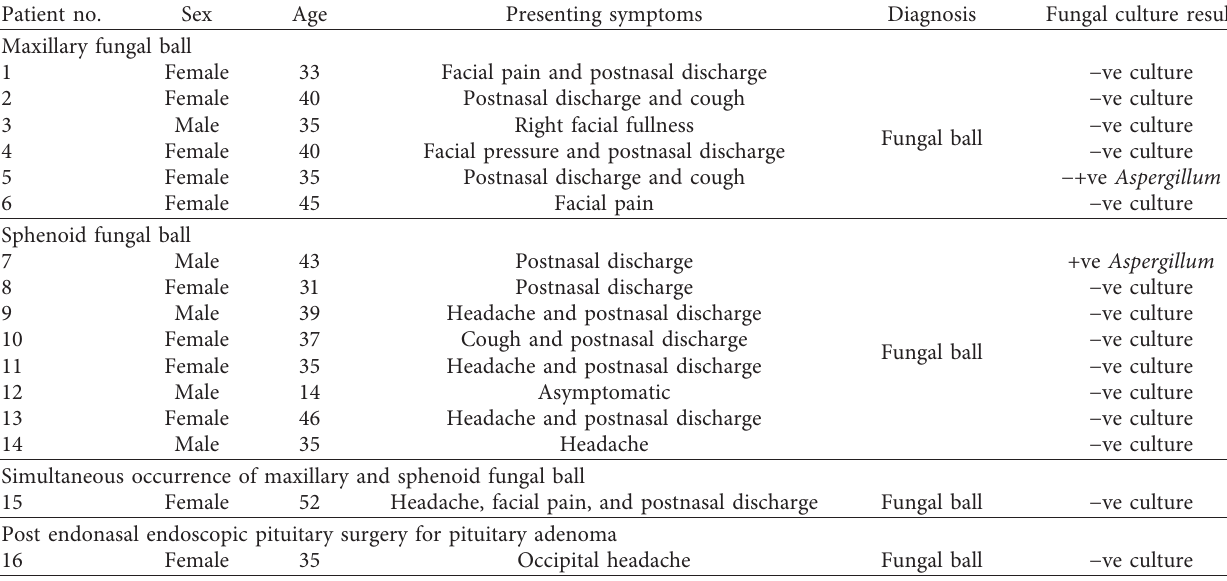
Table 1: Summarizesthetotalof16patientsincludedinthestudyillustratingtheircharacteristics,presentingsymptoms,andfungalballcultureresults. Patient no.